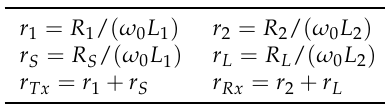
Table 2. Normalized quantities for